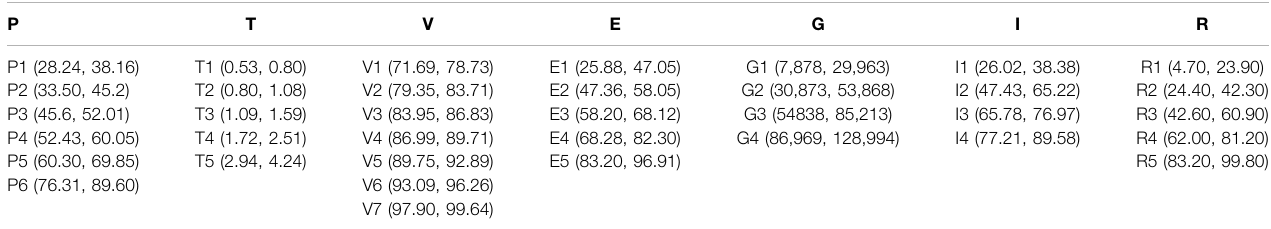
TABLE 1 | Discretization of the socio-economic development (SED) indicators and rural harmless sanitary toilets (RHST) penetration rate for association rule mining. P T V